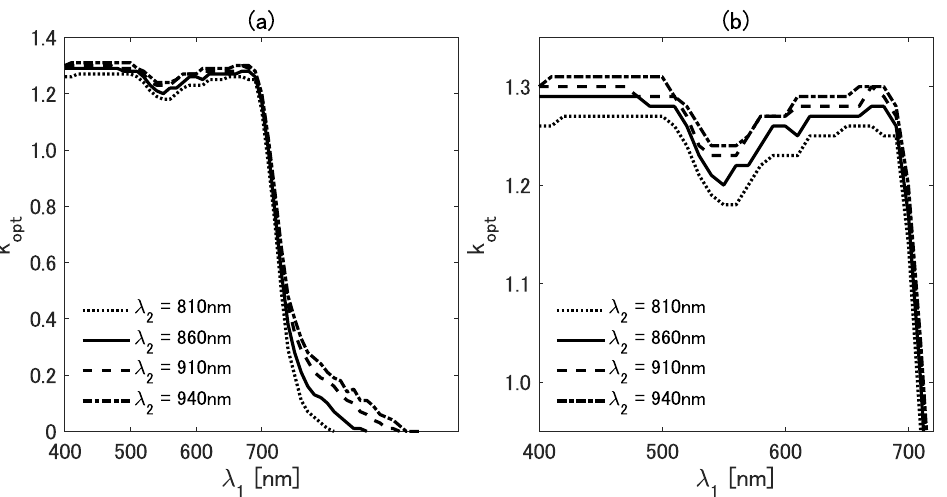
Figure 3. ( a ) The value of k opt as a function of λ 1 for four λ 2 wavelengths (810, 860, 910, and 940 nm). ( b ) Enlarged view of ( a ) in the range from 400 to 700